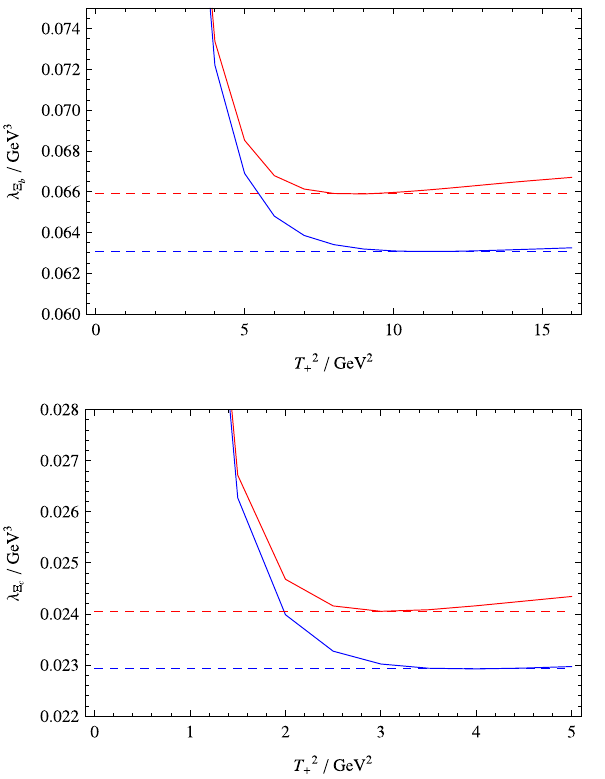
Fig. 4 The pole residues of (cid:2) b (top left), (cid:3) b (top right), (cid:2) c (bottom left) and (cid:3) c (bottom right) as functions of the Borel parameters T 2 + . The blue and red curves correspond to optimal and suboptimal choices for s + . The extreme points of these curves correspond to the optimal choices of T 2 + on these curves. The explicit values for these s + and